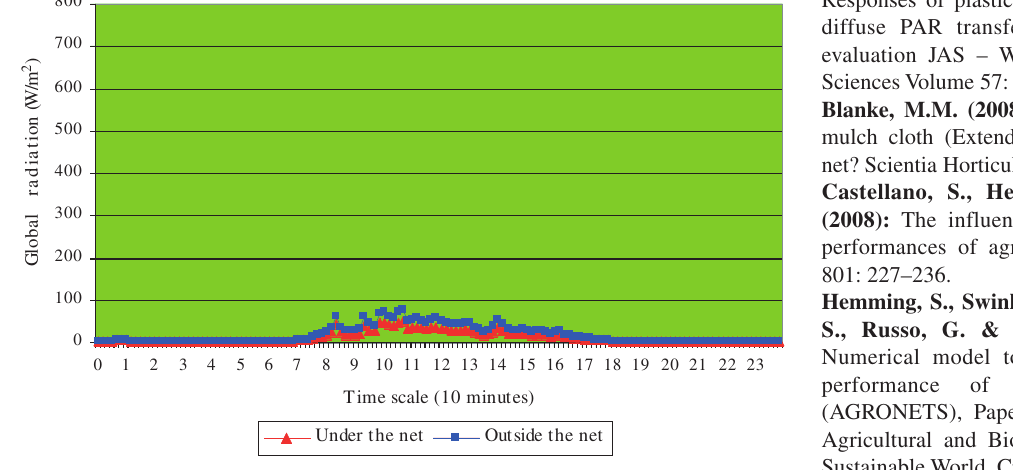
Figure 9. The mean daily course of global radiation under the hail net and outside of it on cloudy days /Pallag 2011 June 1 – September